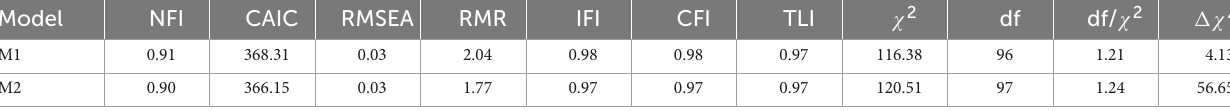
TABLE 4 Goodness of fit indices for two tested models.